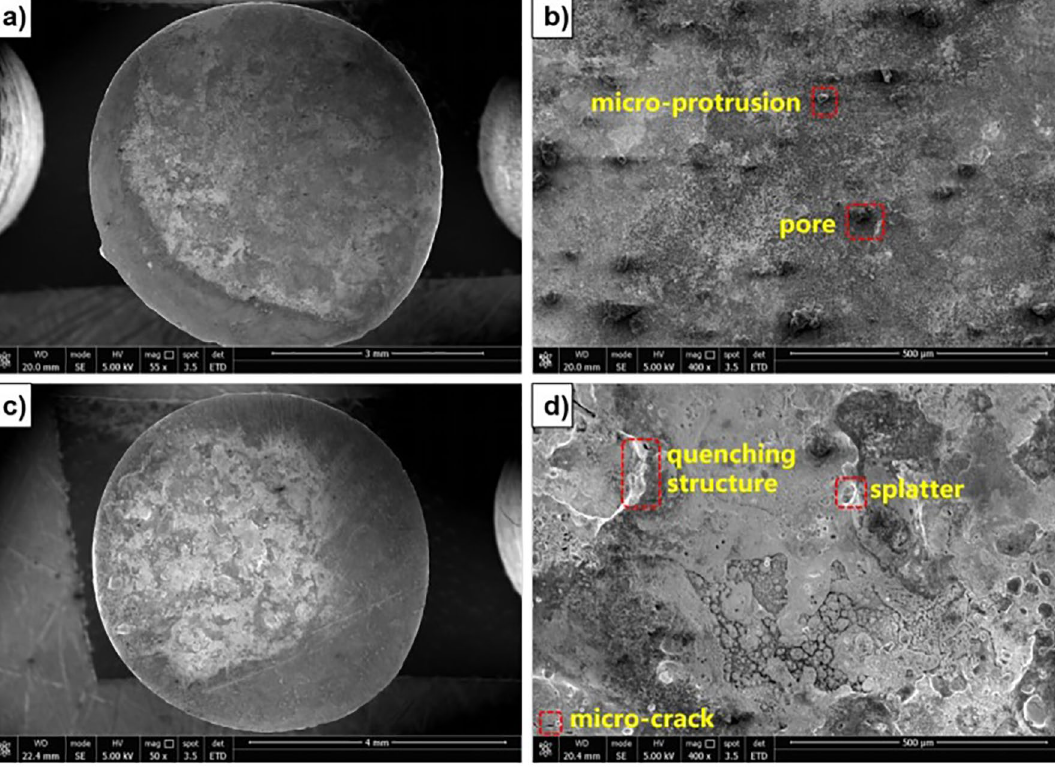
Figure 4. SEM macroscopic surface morphology a) and microscopic morphology b) of Cu-SnO macroscopic surface morphology c) and microscopic morphology d) of Cu-ZnO